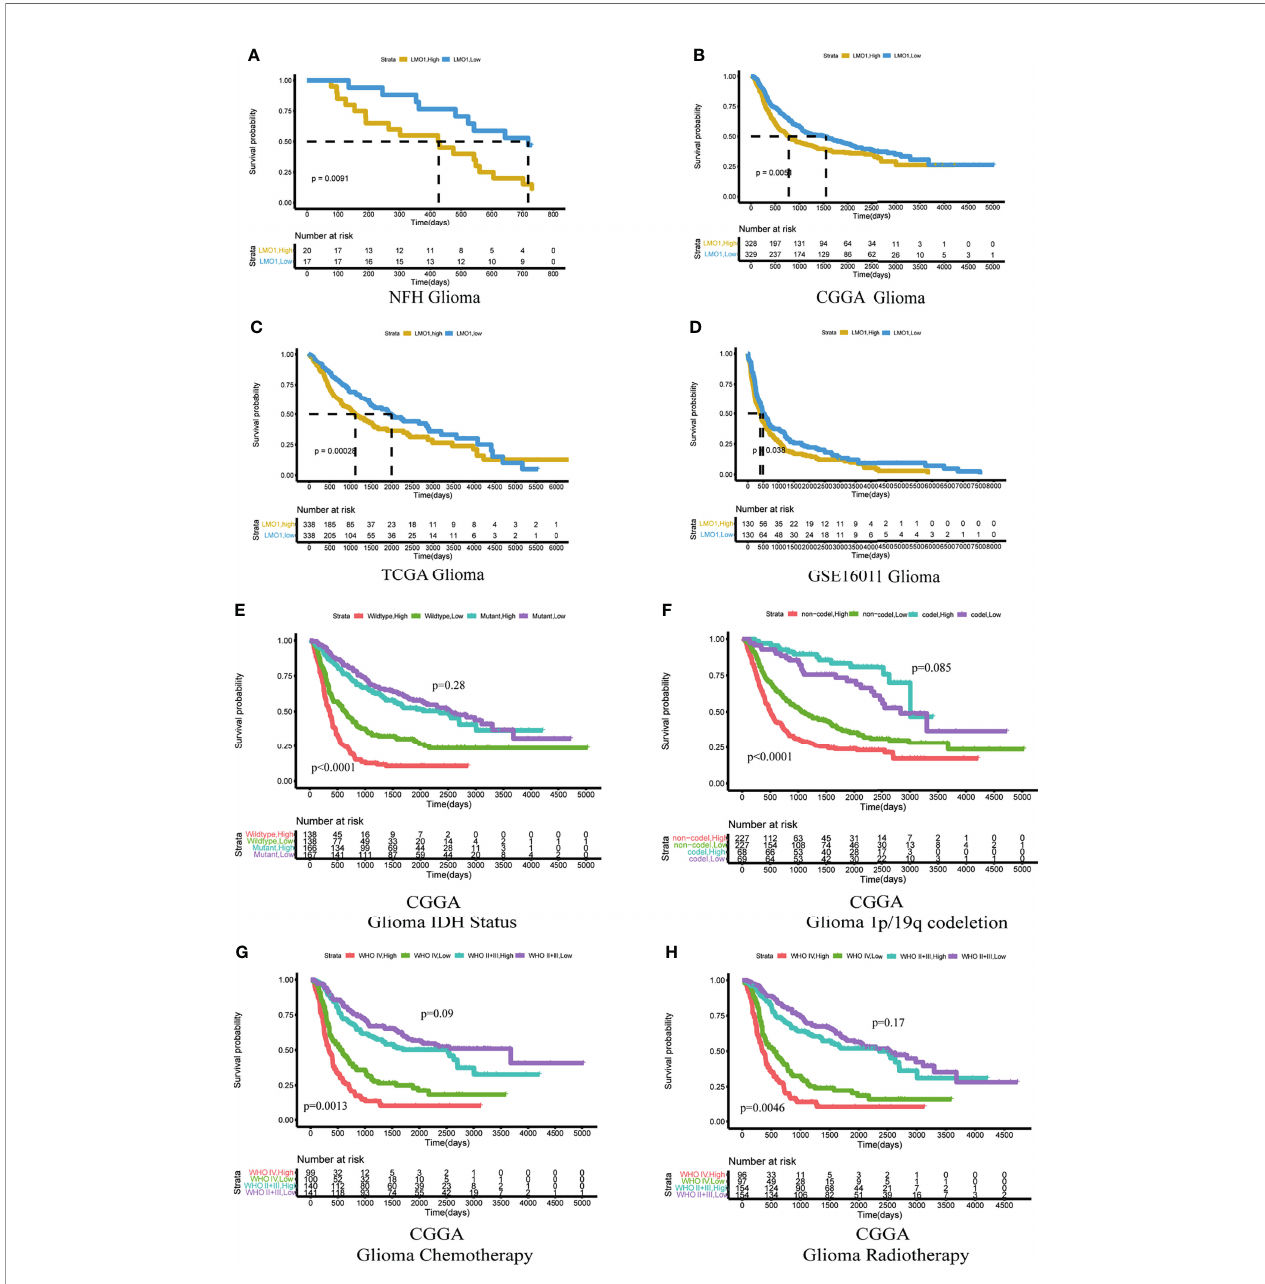
FIGURE 2 | High expression of LMO1 predicts poor clinical outcomes in human gliomas and the response to chemo- and radio-therapy. (A) Survival curves including all glioma patients enrolled at NFH strati fi ed by the IHC staining score for LMO1. an IHC staining score of 6 was regarded as the cutoff. The log-rank test was used to calculate the p-value. (B – D) Survival curves of glioma patients in the CGGA dataset (B) , TCGA dataset (C) and GSE16011 dataset (D) strati fi ed by LMO1 expression. The median mRNA expression level was regarded as the cutoff between high and low LMO1 expression. (E, F) Kaplan – Meier analysis of the survival of glioma patients considering the mutation status of IDH(E)or 1p/19q codeletion status (F) from the CGGA according to LMO1 expression. (G, H) Kaplan – Meier analysis of the survival of glioma or GBM patients treated with chemotherapy (G) or radiotherapy (H) from the CGGA according to LMO1 expression. Log-rank tests were used to calculate